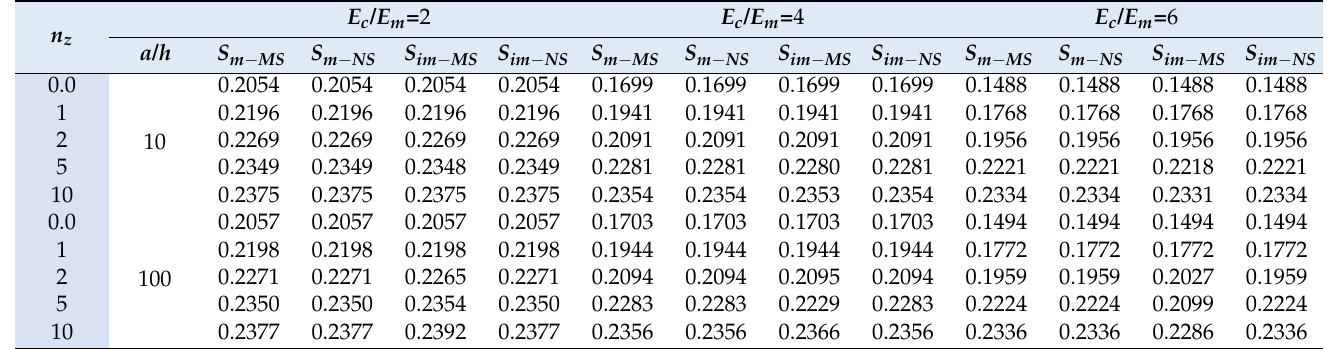
Influence of Young’s modulus ratio ( E c / E m ) on the non-dimensional stress